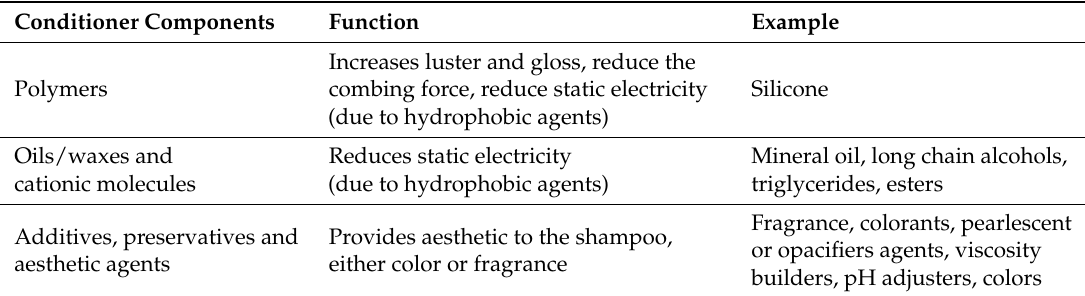
Table 2. Conditioner formulation components